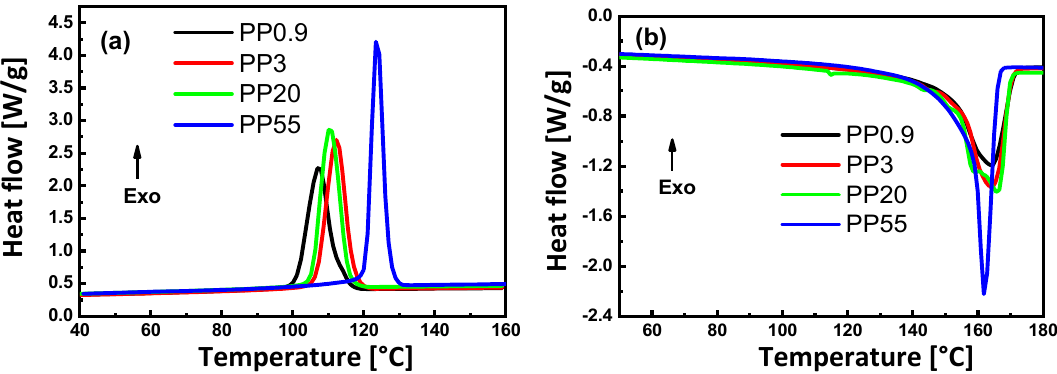
Figure 3. Thermal characterization for native polypropylene samples (PP0.9, PP3, PP20, and PP55) of